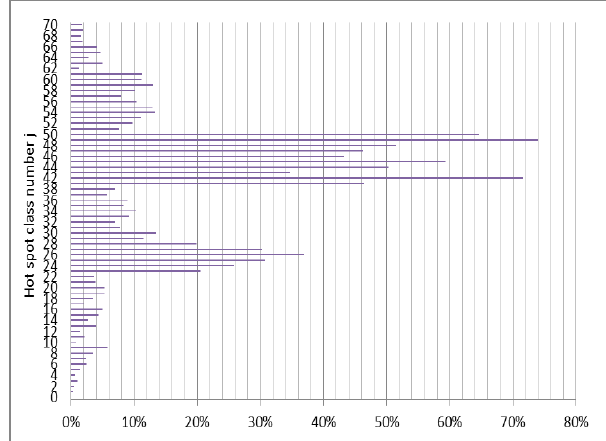
Figure 2. Ratio of each individual access area and all access to WebGIS hot access areas